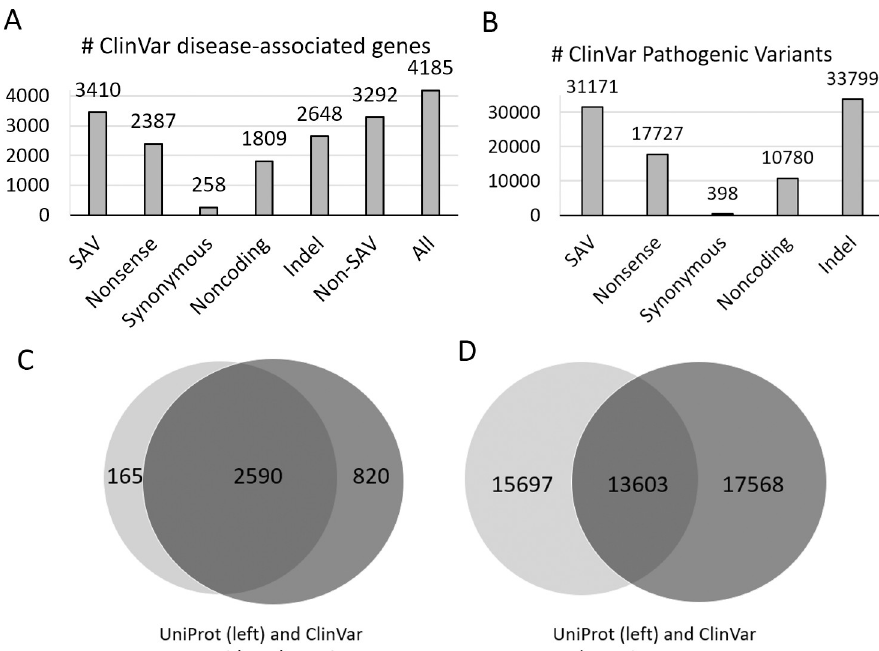
Fig 1. Distribution of disease-associated genes and variants. A) The number of ClinVar disease-associated genes with different types of variants. The non-SAV category combines the categories of nonsense, synonymous, noncoding, and indel. B) The number of variants of different types in ClinVar disease-associated genes. C) Venn diagram of genes with pathogenic SAVs from UniProt and ClinVar. D). Venn diagram of pathogenic variants from UniProt and